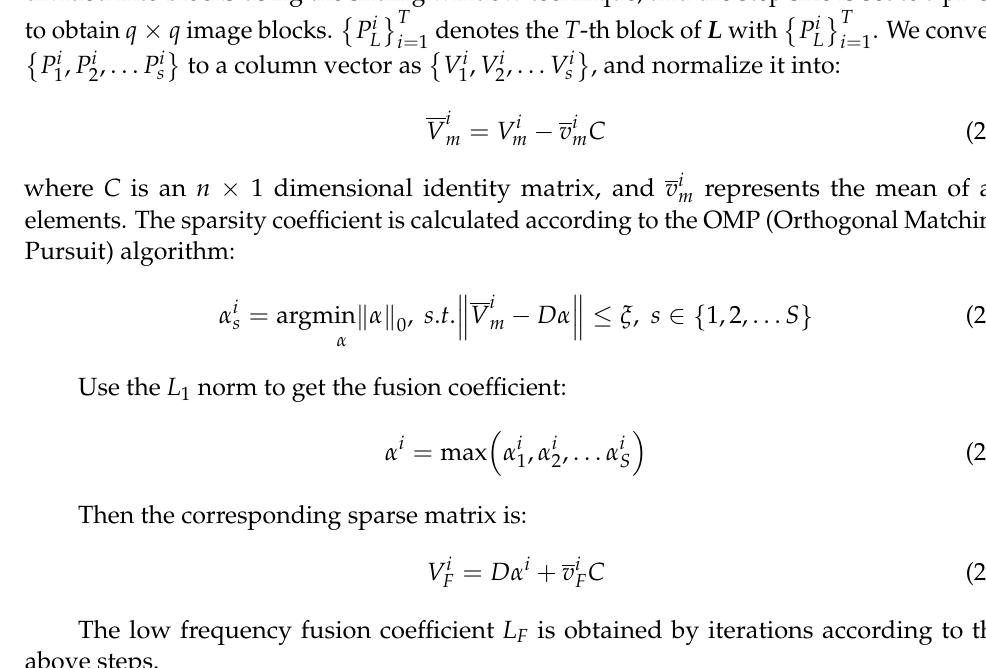
(cid:9) T (cid:8) P i denotes the T -th block of L with L i = 1